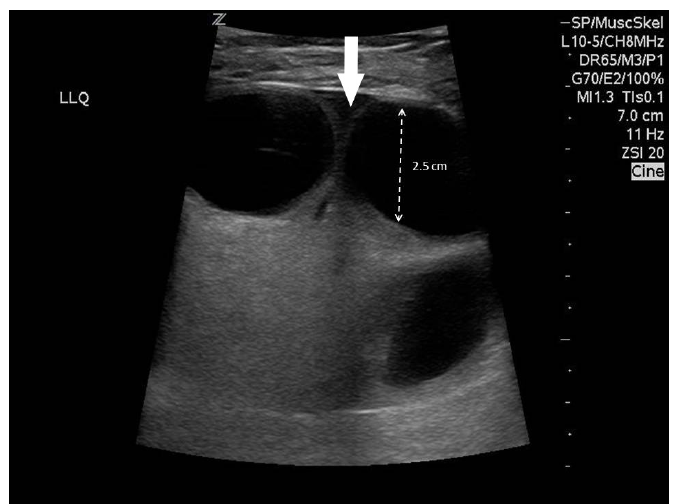
Figure. Dilated fluid-filled loops of bowel visible within a herniating mass. Fluid is seen between bowel loops